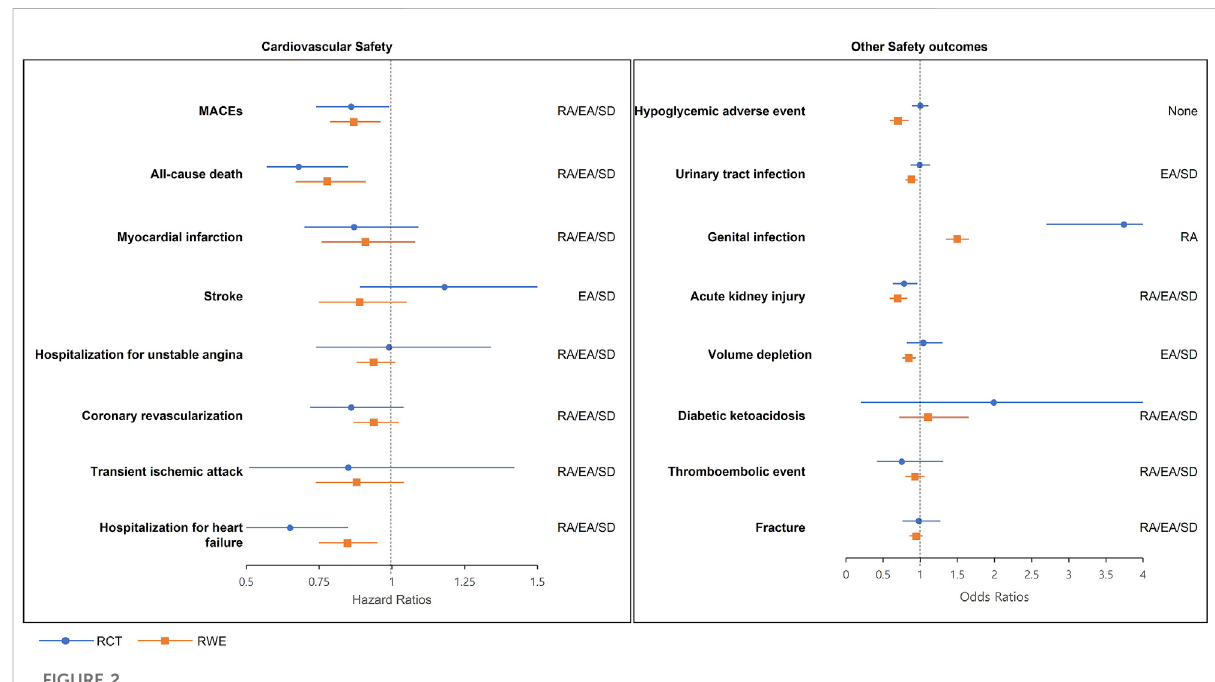
FIGURE 2 RCT-RWE agreements plots. EA, estimate agreement; MACEs, major adverse cardiovascular events; RA, regulatory agreement; RCT, randomized clinical trial; RWE, real-world evidence; SD, standardized